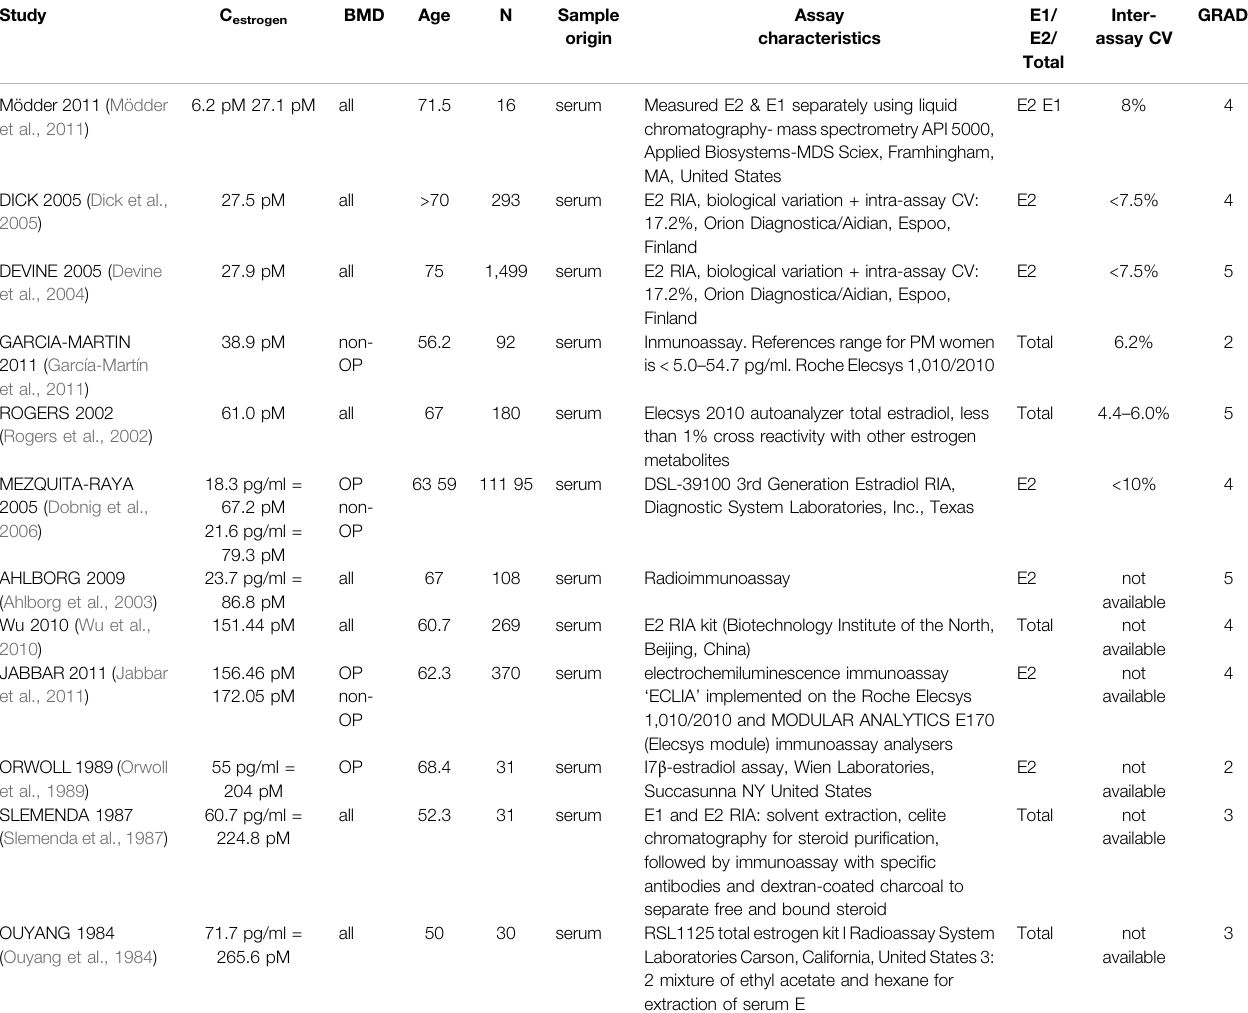
TABLE 6 | Estrogen concentration measurements in postmenopausal women, in ascending order.